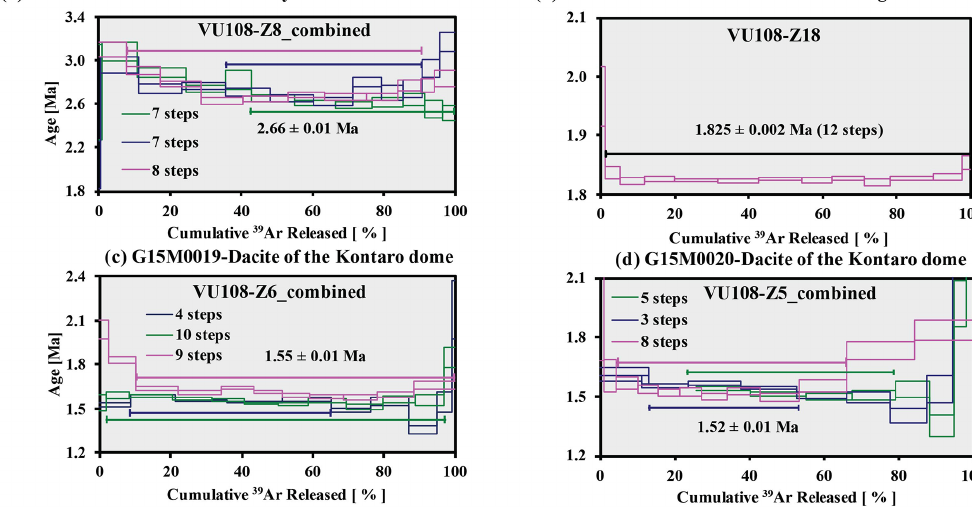
Figure 5. Groundmass 40 Ar / 39 Ar plateau ages for samples G15M0016 (a) , G15M0032B (b) , G15M0019 (c) and G15M0020 (d) . The Mavro Vouni dome (a) , Dhemeneghaki volcano (b) and Kontaro dacitic dome (c,d) are located in, respectively, the south-western, north- eastern and eastern parts of the Milos VF (see Fig. 2). Final age calculation is reported with 1 σ errors. See the individual steps of samples G15M0016, G15M0019 and G15M0029 in Supplement file II.